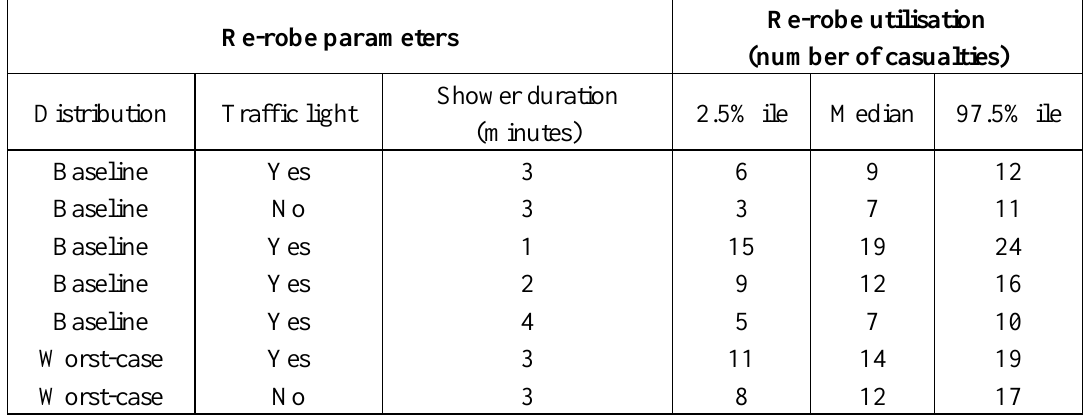
Table 1. The number of casualties present in one lane of the re-robe section (utilisation) with an unlimited re-robe capacity and with different parameter